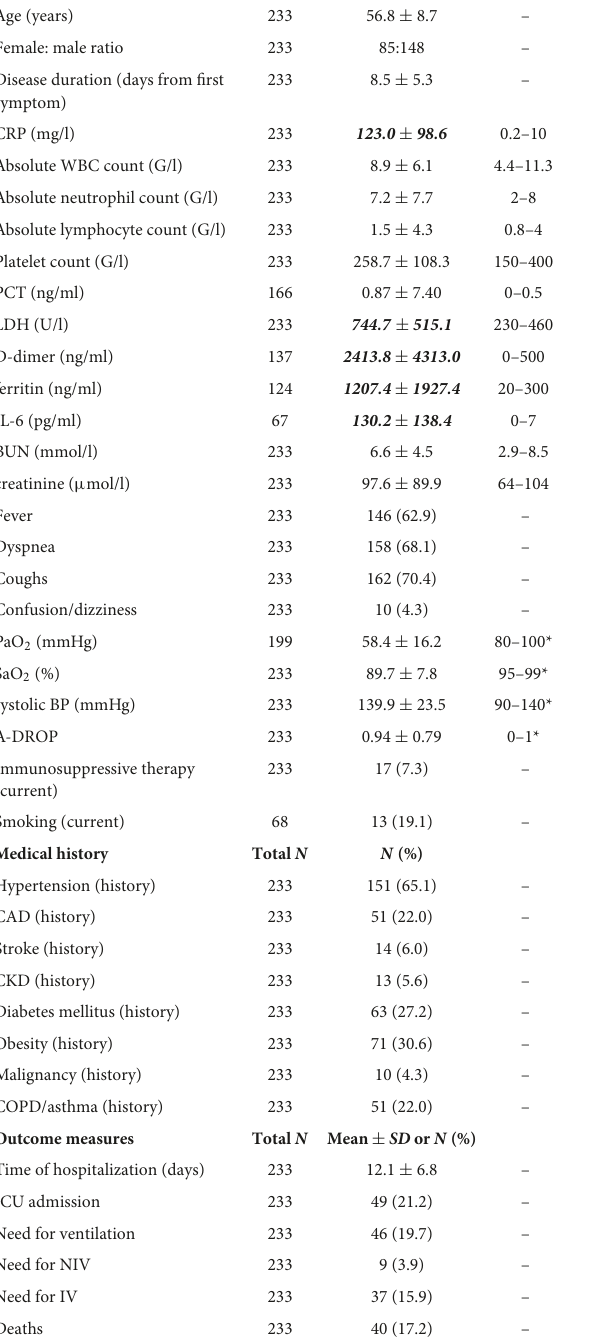
TABLE 1 Patient characteristics.